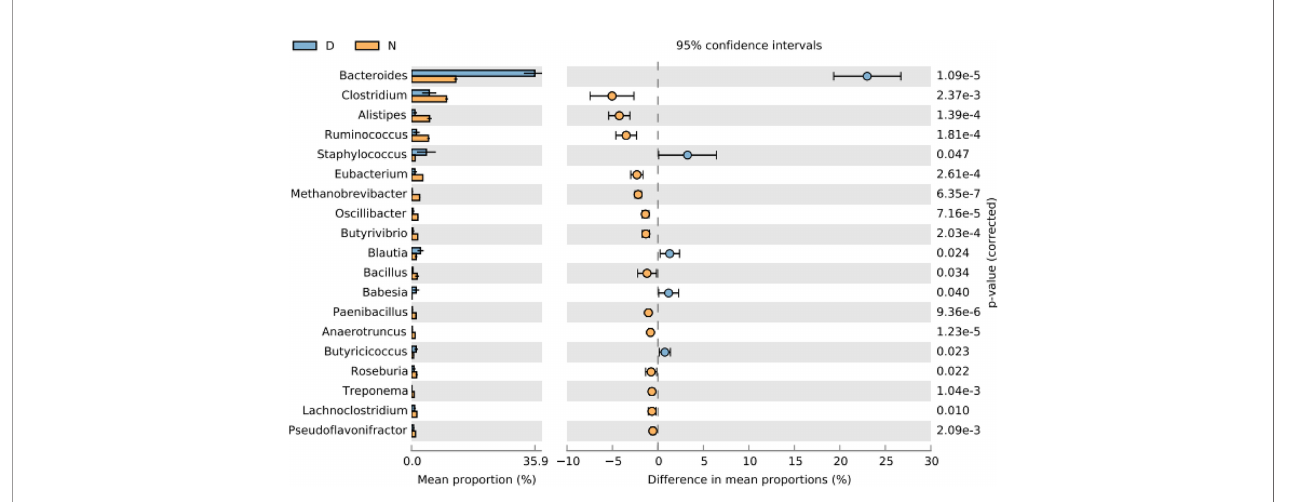
FIGURE 2 | Comparing intestinal microbiota difference between different yaks at genus level. D, diarrheal group samples; N, normal group samples.